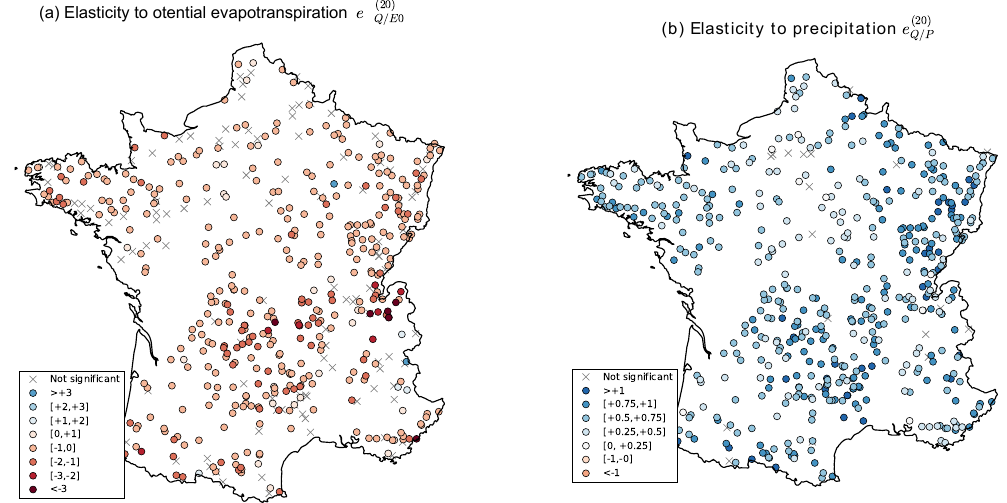
Figure 9. Regional analysis of (a) streamflow elasticity to precipitation and (b) streamflow elasticity to potential evaporation. Elasticity values were obtained by the GLS2 regression method using 20-year sub-periods. Each dot represents a catchment outlet; the color represents the elasticity value. Those catchments where the linear correlation was found to be nonsignificant are indicated with a